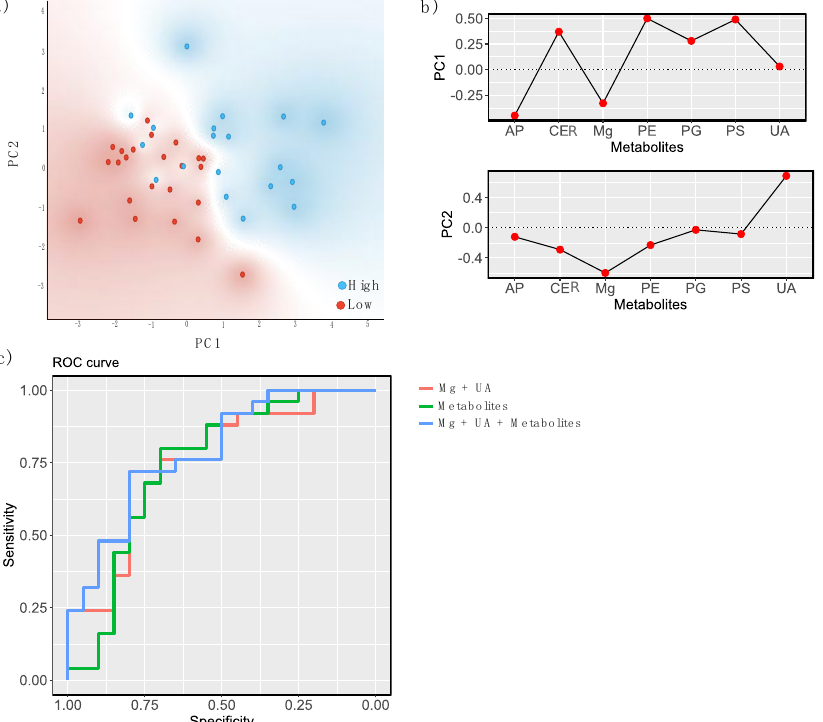
Figure 3. ( a ) The distribution of principal component (PC) score values (PC1 and PC2) of patients with metabolic profiles associated with low and high tacrolinemia. ( b ) Loading plots of the first two PCs yielded by PC analysis. ( c ) Head-to-head comparison of the receiver operating characteristic curves (ROC) for the classification accuracy yielded by magnesium, uric acid, the five metabolites (phosphatidylserine 44:8, phosphatidylglycerol 36:6, phosphatidylethanolamine 36:4, arachidyl palmi- toleate C36:1, and ceramide t18:0/22:0(2OH)), and their combination using naïve Bayes analysis for supervised